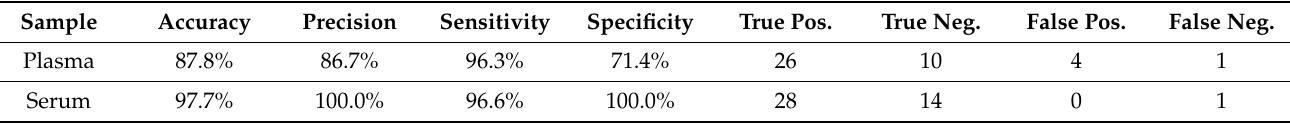
Table 3. PCA-LDA results on plasma and serum samples for 1200–1700 cm − 1 spectral Table 2. PCA-LDA results on plasma and serum samples.